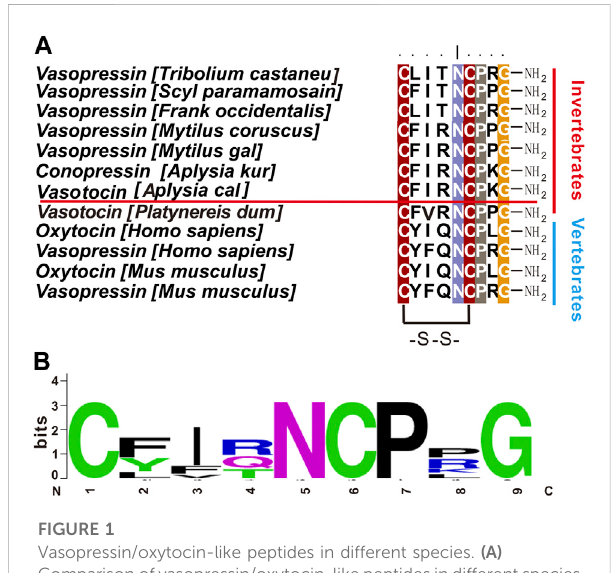
Vasopressin/oxytocin-like peptides in different species. (A) Comparison ofvasopressin/oxytocin-like peptidesin differentspecies using BioEdit (ClustalW Multiple alignments — Graphic View). Aplysia vasotocin is underlined. (B) A frequency plotfor thesequences in (A) using Weblogo v2.8.2 (http://weblogo.berkeley.edu/logo.cgi). Other than the two cysteine residues, residues at positions 5, 7, 9 are also highly